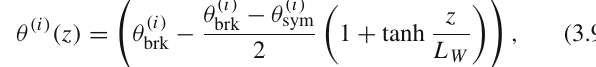
Fig. 1 Normalised deviation from the straight line path at each step i along the path where (cid:13) ω l are the points along the direct line from (cid:13) ω s to (cid:13) ω (cid:13) ω b . p referstothefoundglobalminimumintheorthogonalplanes.The colour code denotes the various possible minima, ω 1 (red), ω 2 (blue) and ω CP (green). Red and blue points are on top of each other and are almost zero